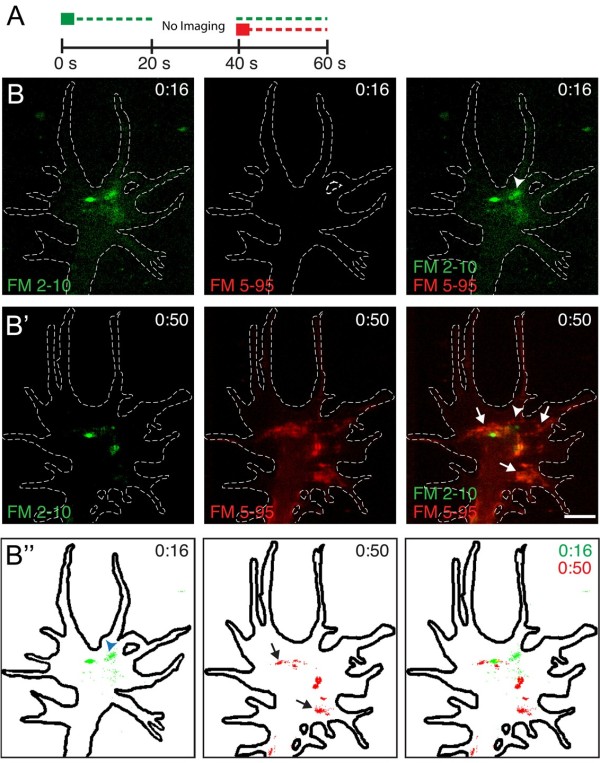
Sequential dye labeling demonstrates temporally distinct endocytic zones. (A) Illustration of the dual FM dye membrane labeling assay. A micropipette first applied a focal pulse of FM 2-10 (green square, t = 0 s) and confocal images were collected for 20 s. After an additional 20 s interval, a second micropipette applied a focal pulse of FM 5-95 at time 40 s (red square) and confocal images were collected for an additional 20 s. The broken lines depict the presence of the respective FM dyes. (B-C) Time-lapse confocal images of a representative growth cone subjected to the dual FM dye labeling assay described in (A). (B) Confocal images of FM 2-10 internalization following the initial dye pulse, applied at t = 0:00, show labeled endocytic structures in the growth cone. The white arrowhead marks an endocytic zone. Time (minutes:seconds) following the FM 2-10 pulse is depicted in each frame. (B') Confocal images of the same growth cone following a second dye pulse (FM 5-95, red) show dye labeled nascent vesicles, most of which were not labeled by the prior FM 2-10 pulse. Importantly, the majority of nascent vesicles labeled by FM 5-95 (right panel, white arrows) formed in locations spatially distinct from regions where FM 2-10-positive vesicles had formed (right panel, white arrowhead). Time (min:s) following the initial FM 2-10 dye pulse is indicated in each frame. (B'') Binary images, generated from the fluorescence images in B (0:16) and B' (0:50), show distinct endocytic zones during the two FM dye pulses applied at 40-s intervals. See Additional file 11 for the time-lapse movie corresponding to B-B''. Scale bars, 5 μm.